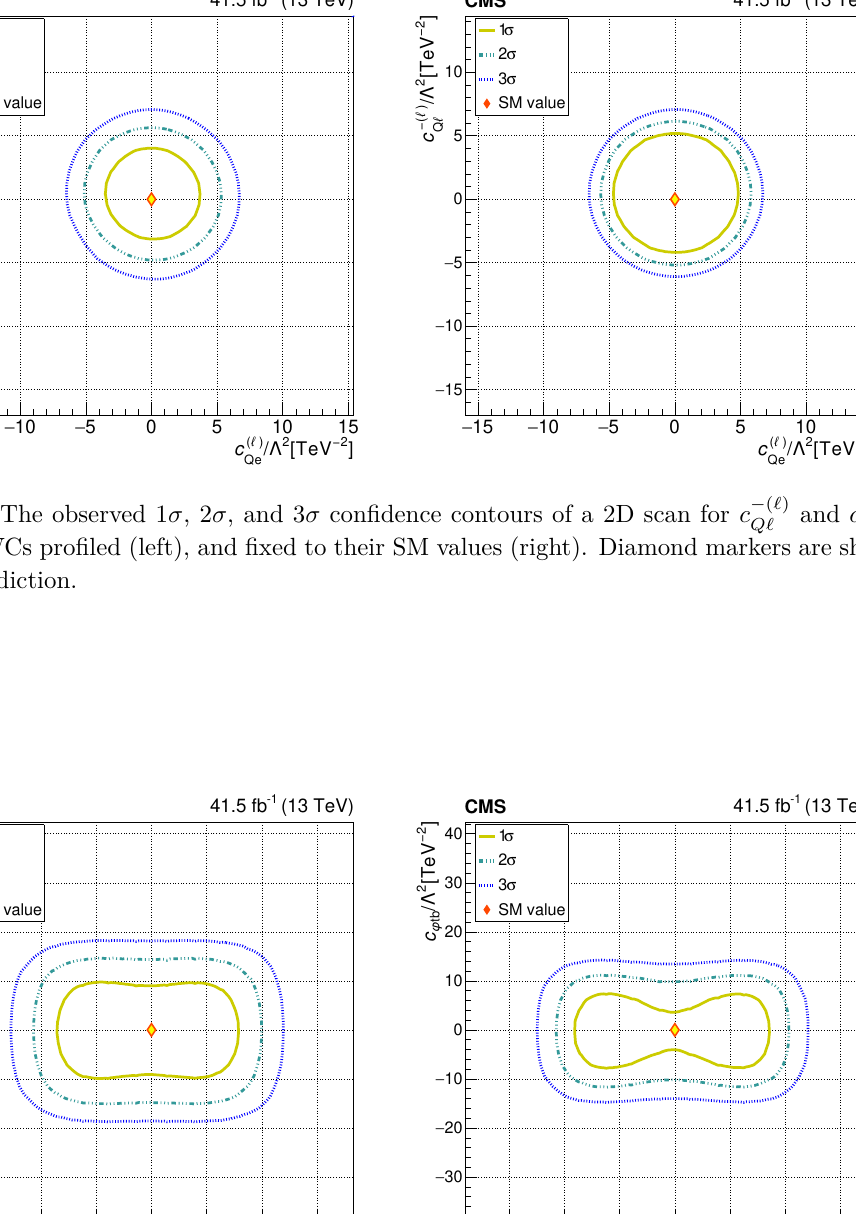
Figure 6 . The observed 1 σ , 2 σ , and 3 σ confidence contours of a 2D scan for c the other WCs profiled (left), and fixed to their SM values (right). Diamond markers are shown for the SM